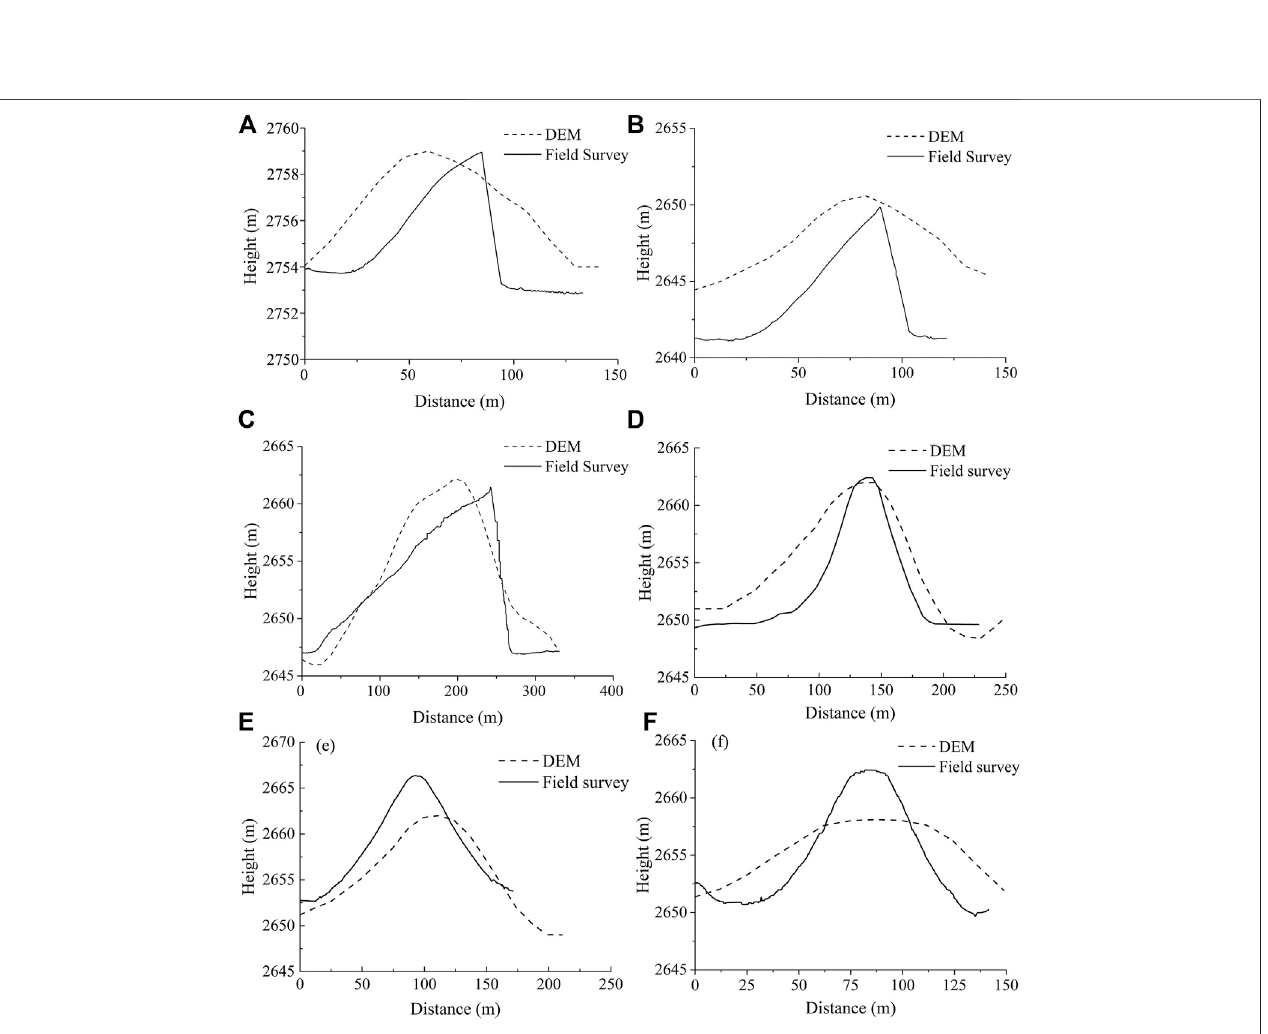
FIGURE 7 | Comparison of dune pro fi les based on a digital elevation model (DEM) and fi eld surveys for (A,B,C) three barchans and (D,E) , and (F) three linear dunes. The barchan coordinates are 93 ° 46 ′ 39.3 ″ E and 37 ° 14 ′ 10.8 ″ N, and the linear dune coordinates are 93 ° 46 ′ 55.99 ″ E and 37 ° 11 ′ 55.84 ″ N.